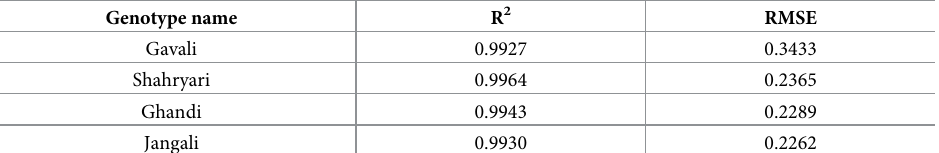
Table 7. Evaluation results of the 2019 data-driven ANN model on the data collected in 2021 from three green- gage plum genotypes and one myrobalan